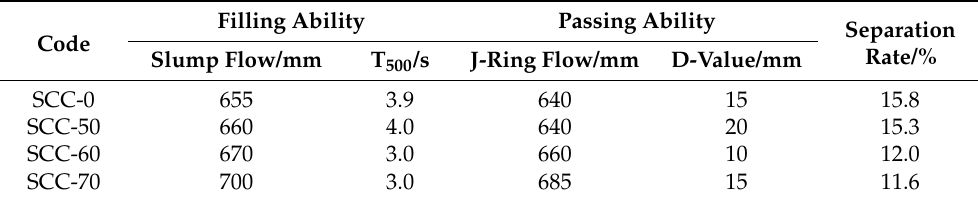
Table 5. Influence of different fly ash content on workability of SCC.